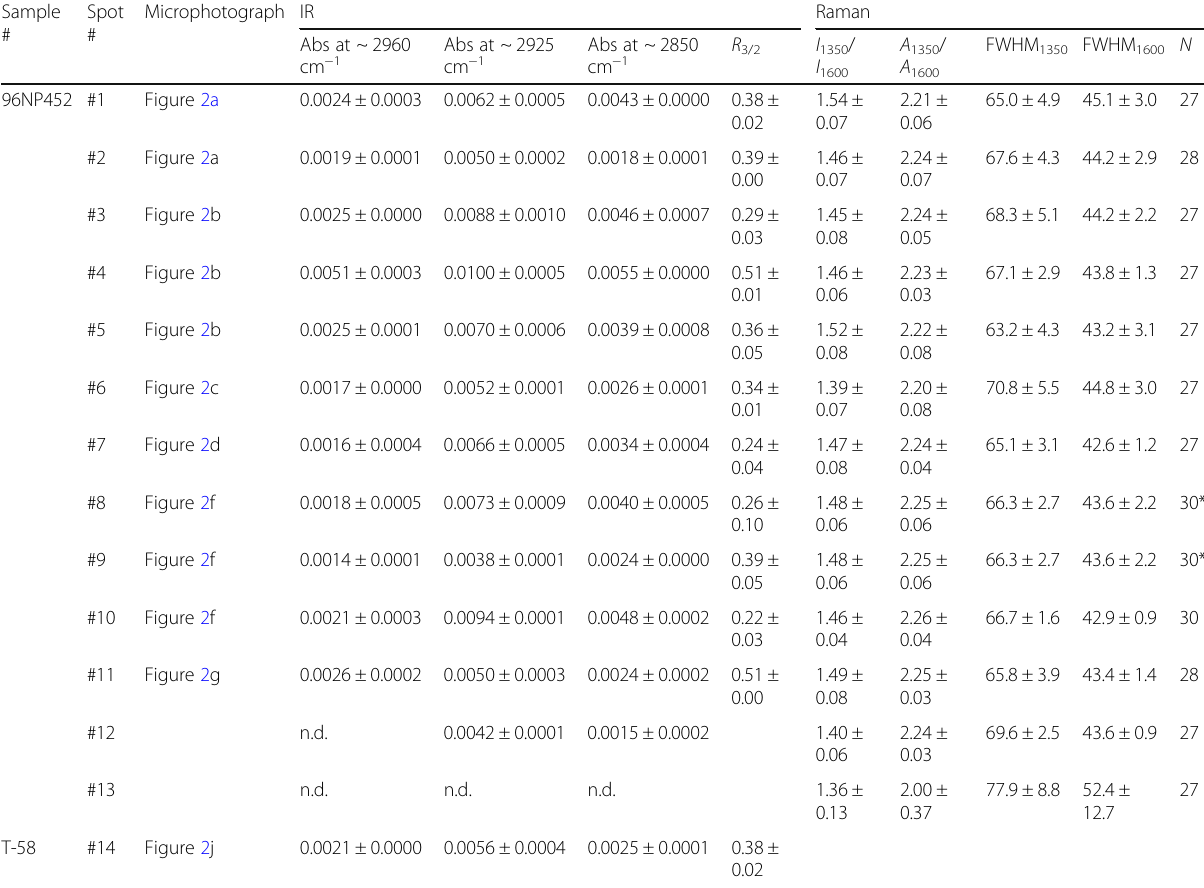
Table 1 IR and Raman parameters for analyzed carbonaceous